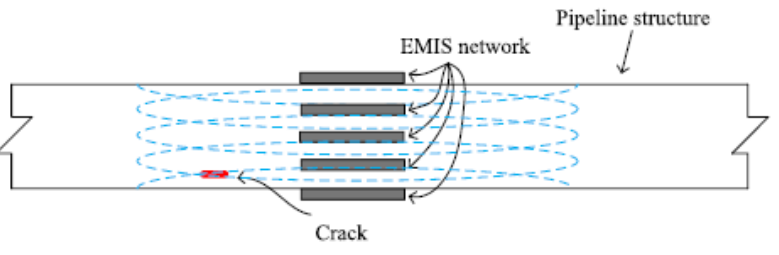
Figure 55. The schematic drawing of an annular setup of EMI sensors. Reprinted from Smart Materials and Structures, Volume 26, Number 10, Zuo, C.; Feng, X.; Zhang, Y.; Zhou, J. Year 2017 with permission from IOP Publishing Limited [144].